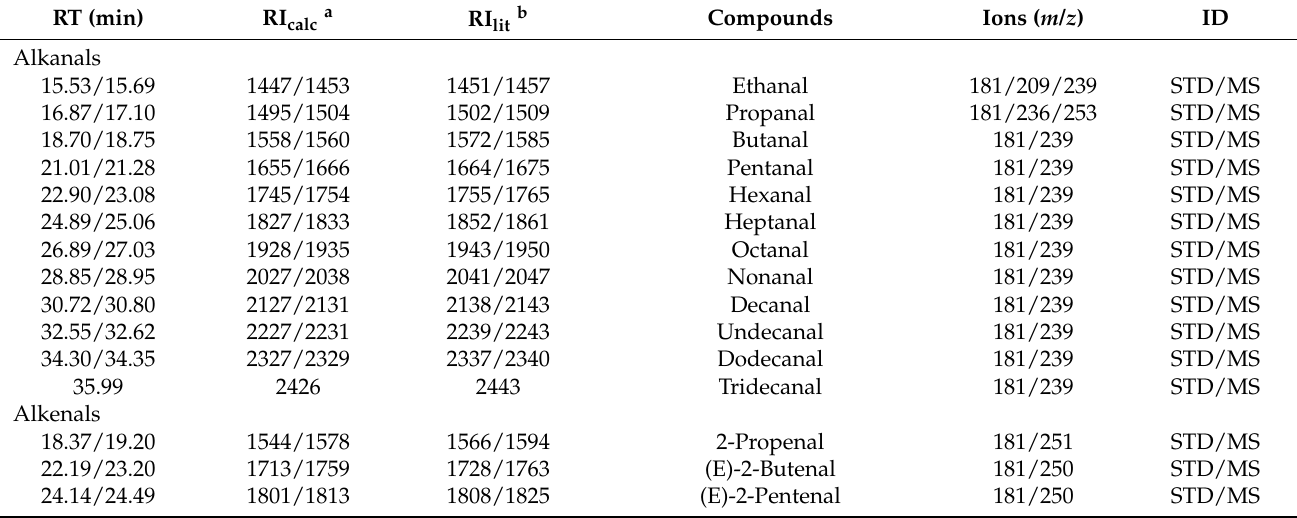
Table 2. Compounds identified in Huangjiu : retention time (RT), retention index (RI), m / z quantitative ion, identification method